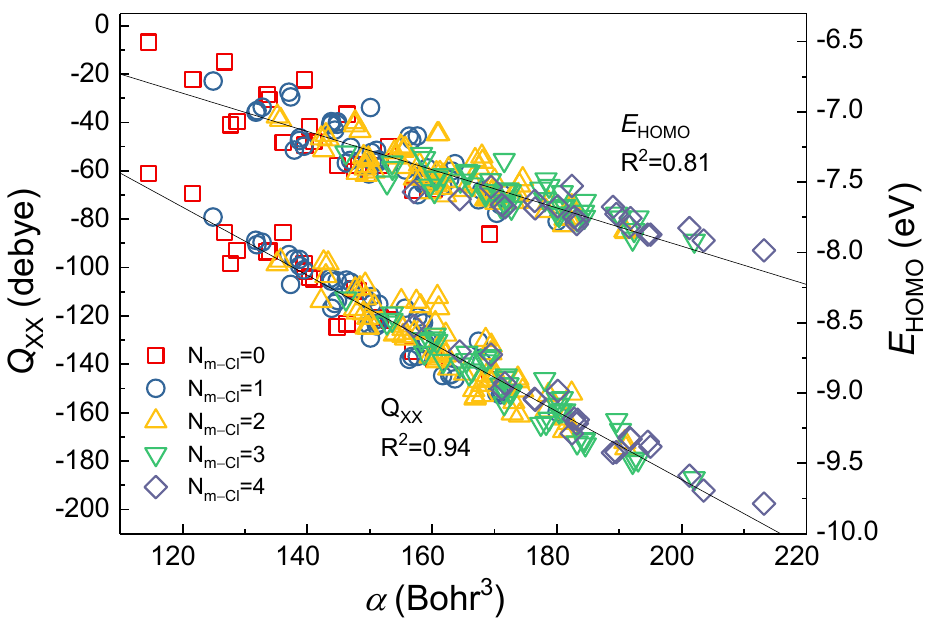
Figure 3. The relationship of α with Q xx and E HOMO of PCBs congeners.